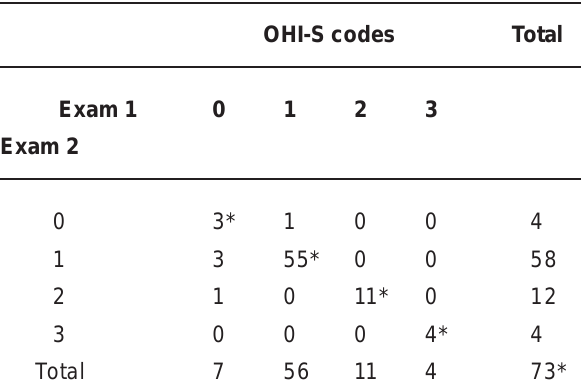
TABLE 1 - 10% of reexaminations of the Simplified Oral Hygiene Index (OHI-S), for calculation of Kappa in students